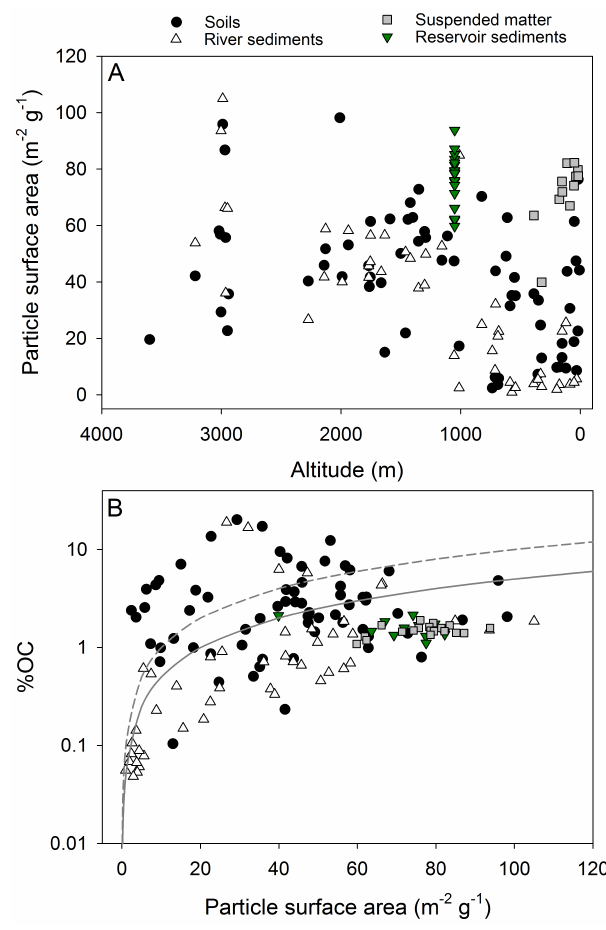
Fig. 9. Profile of (A) altitude vs. SA, (B) SA vs. %OC of soil, sed- iment and suspended matter along Tana River Basin during three sampling seasons. Dashed lines bound the monolayer equivalent lines; region of organic carbon to surface area ratios (OC:SA) of 0.5–1.0mgOCm − 2